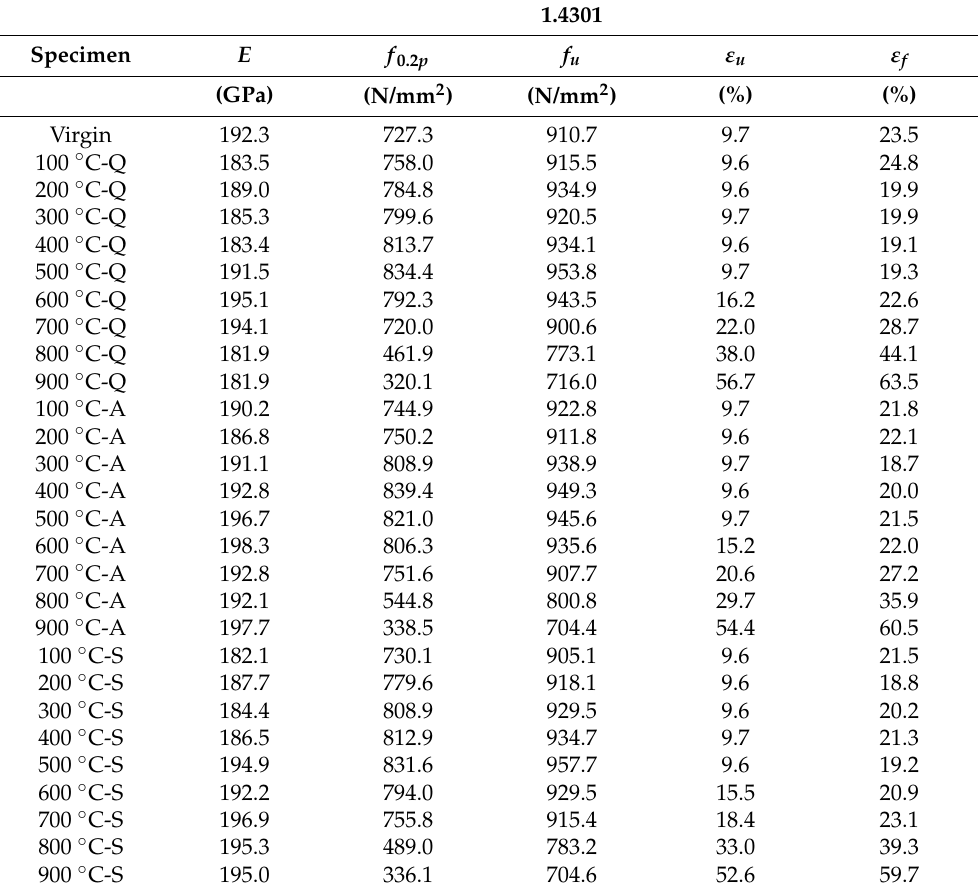
Table 3. Post-fire mechanical properties of grade 1.4301 stainless steel reinforcing bar.